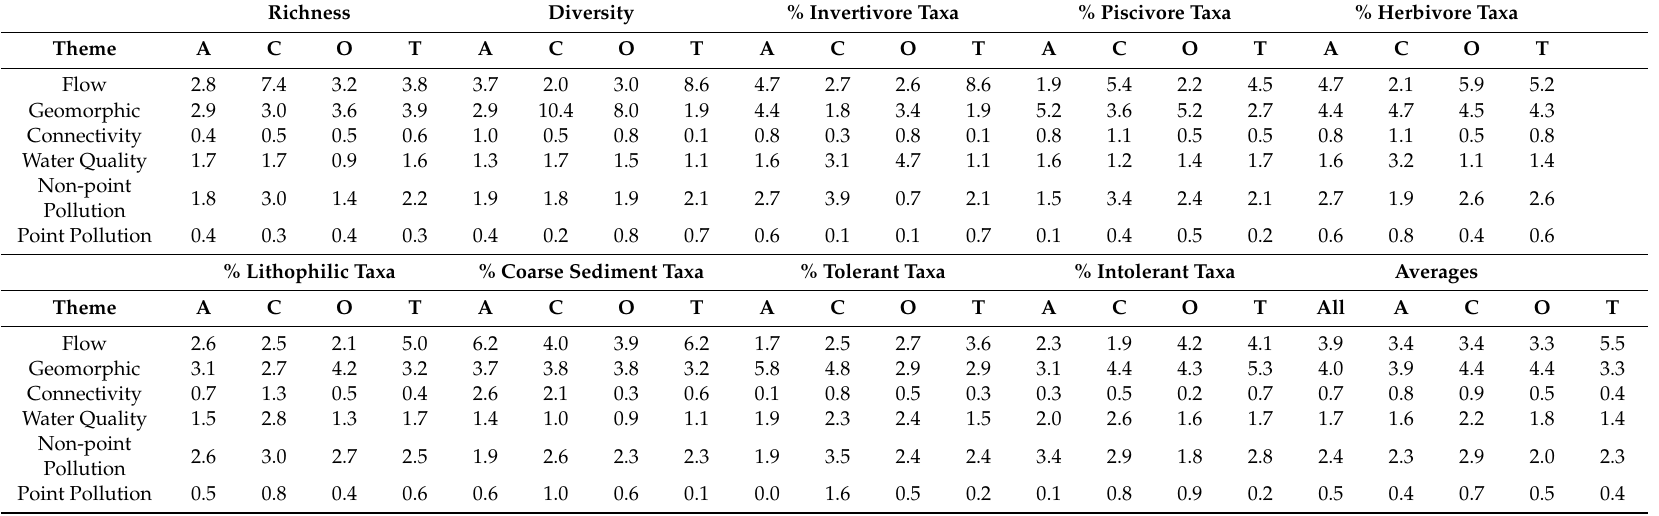
Table 7. Summary of the regional average relative influence for each theme on response variables modeled with the boosted regression trees for fish. The average thematic % relative influence is the percent relative contribution of each theme to the BRT model. Themes are comprised of flow condition (NID storage, dam density, altered streamflow, agricultural and industrial water withdrawals), geomorphic condition (erosive and resistive forces), connectivity (dam and road crossing density at the watershed and catchment levels), water quality (total nitrogen load, total phosphorous load, and dissolved organic carbon), non-point source pollution (% agricultural land cover, % impervious surface, and % natural land cover in the watershed, active river area, and catchment), and point source pollution (CERCLA